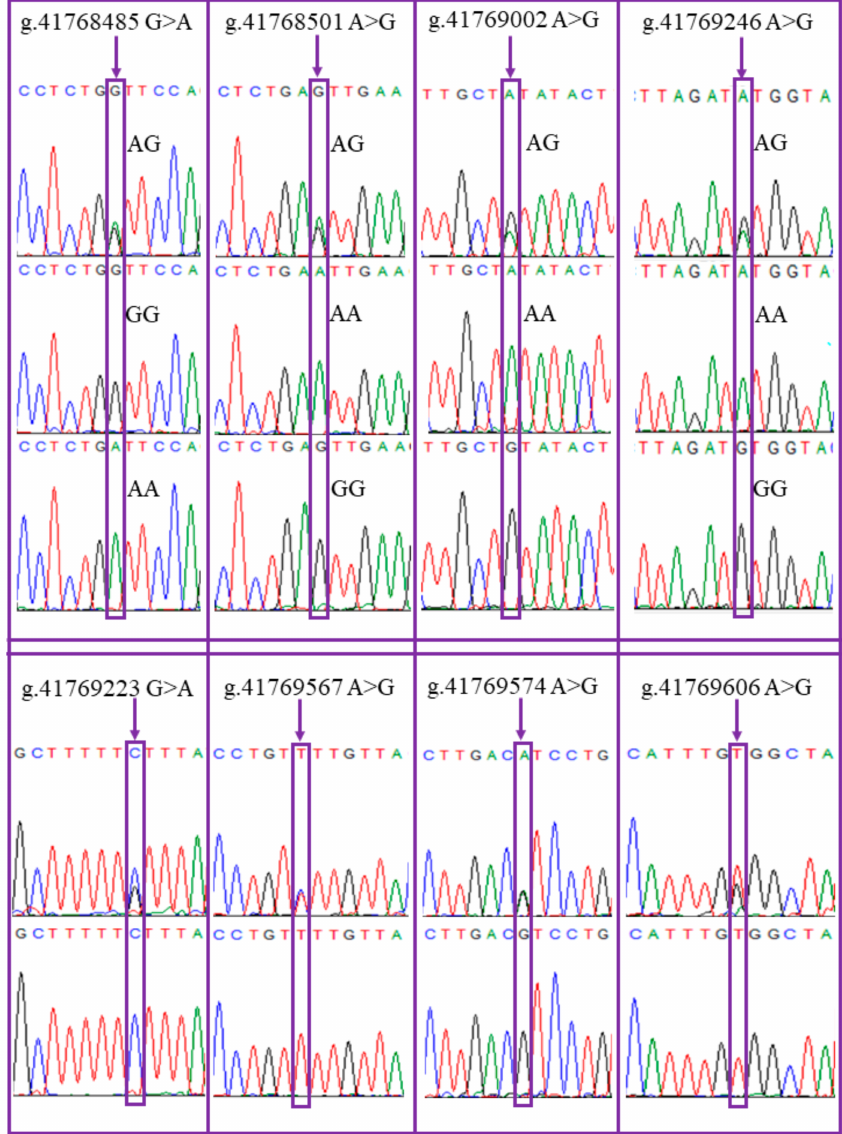
Figure 1. Sequencing profiles around eight mutation loci in the GDF9 gene of Luzhong